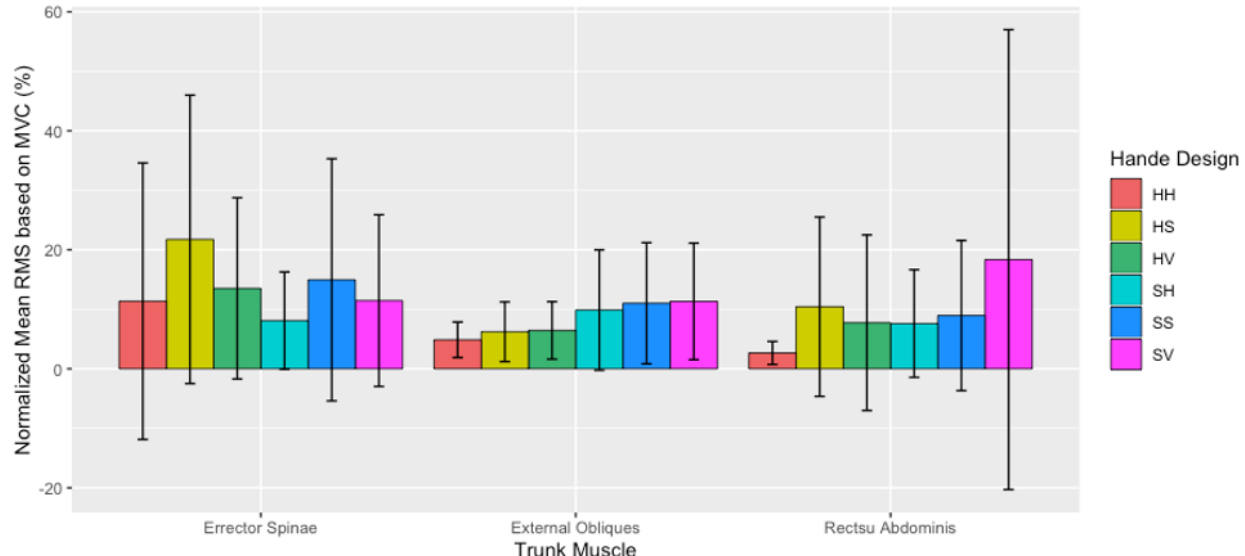
Figure 7. Normalized mean RMS (mean ± SD) based on the percentage (%) of the three trunk muscles between handle designs at the initiation of the push.